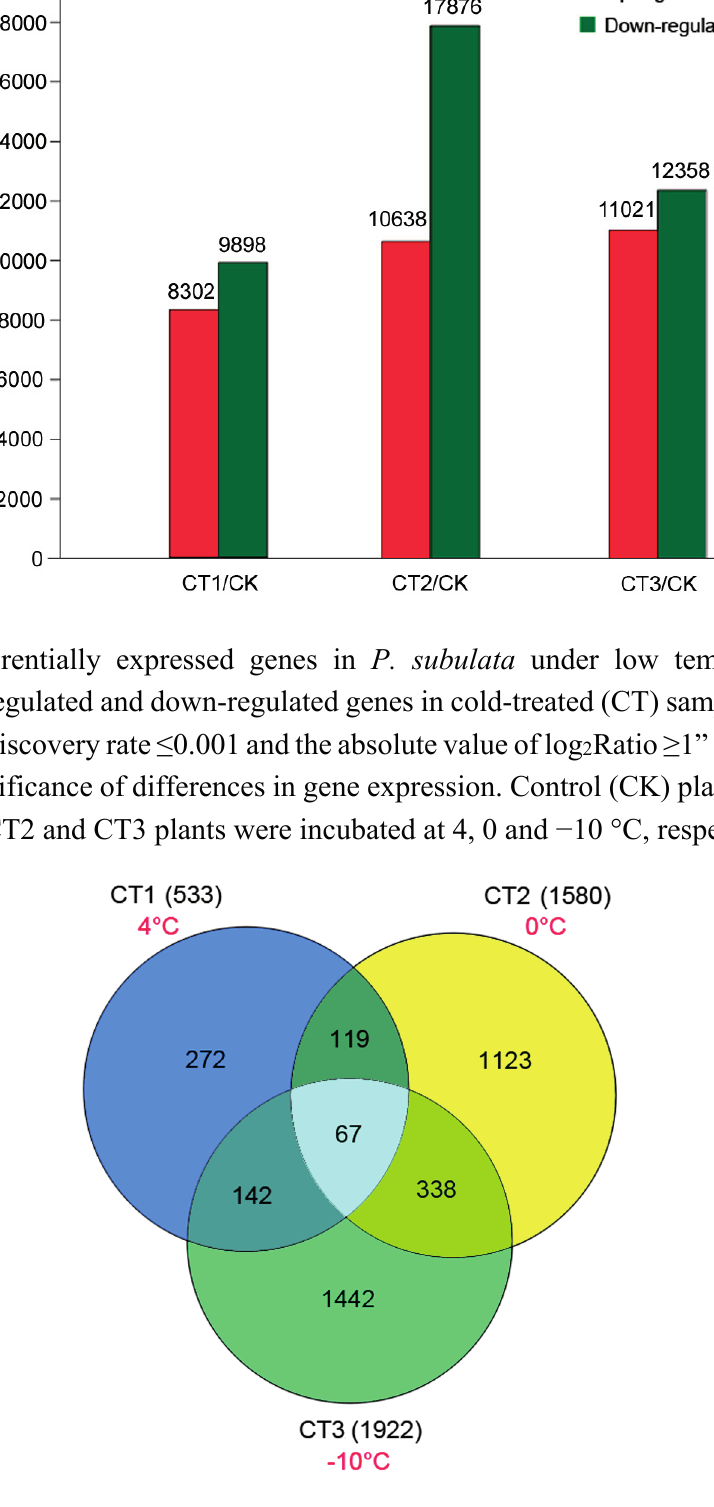
Figure 8. The numbers of up-regulated genes expressed only in the three CT samples (4, 0, and –10